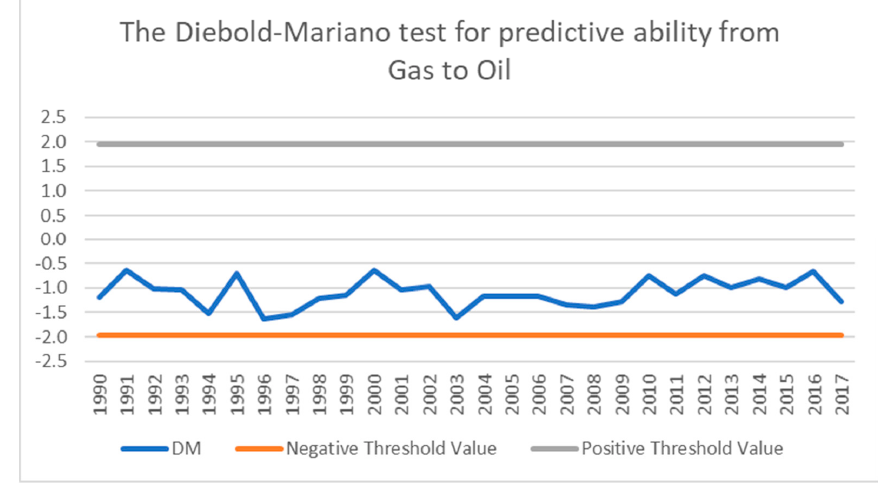
Figure 5. The Diebold-Mariano test for predictive ability from gas to oil.